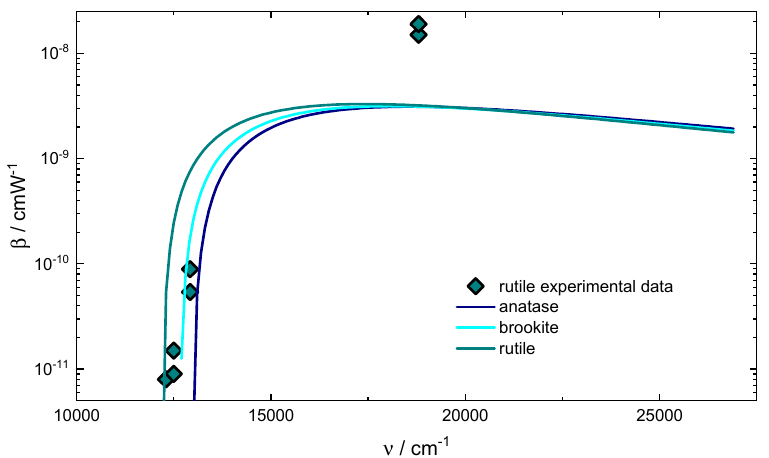
Figure 1. Two-photon absorption (TPA) coefficient as calculated from Equation (1) for crystalline TiO 2 modifications (solid lines; input data according to Table 1). Symbols: experimental data reported in References [19,25] for rutile, as obtained from Z-scan techniques.